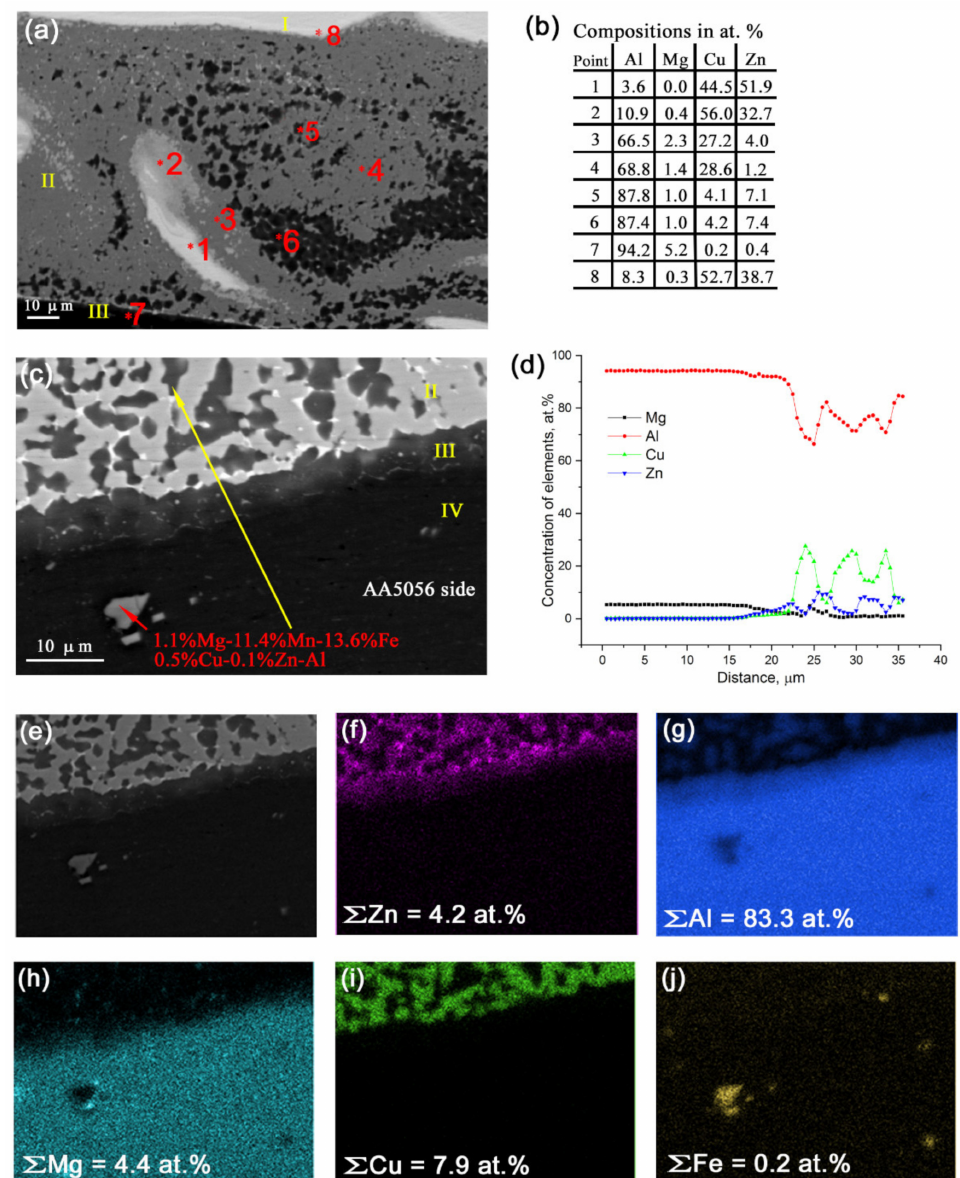
Figure 6. Different regions found in the bottom part of the SZ ( a , c ), EDS element concentrations in zones 1 to 8 in Figure 6a ( b ) and EDS profiles along the line in Figure 6c ( d ); EDS element maps ( f – j ) obtained from image ( e